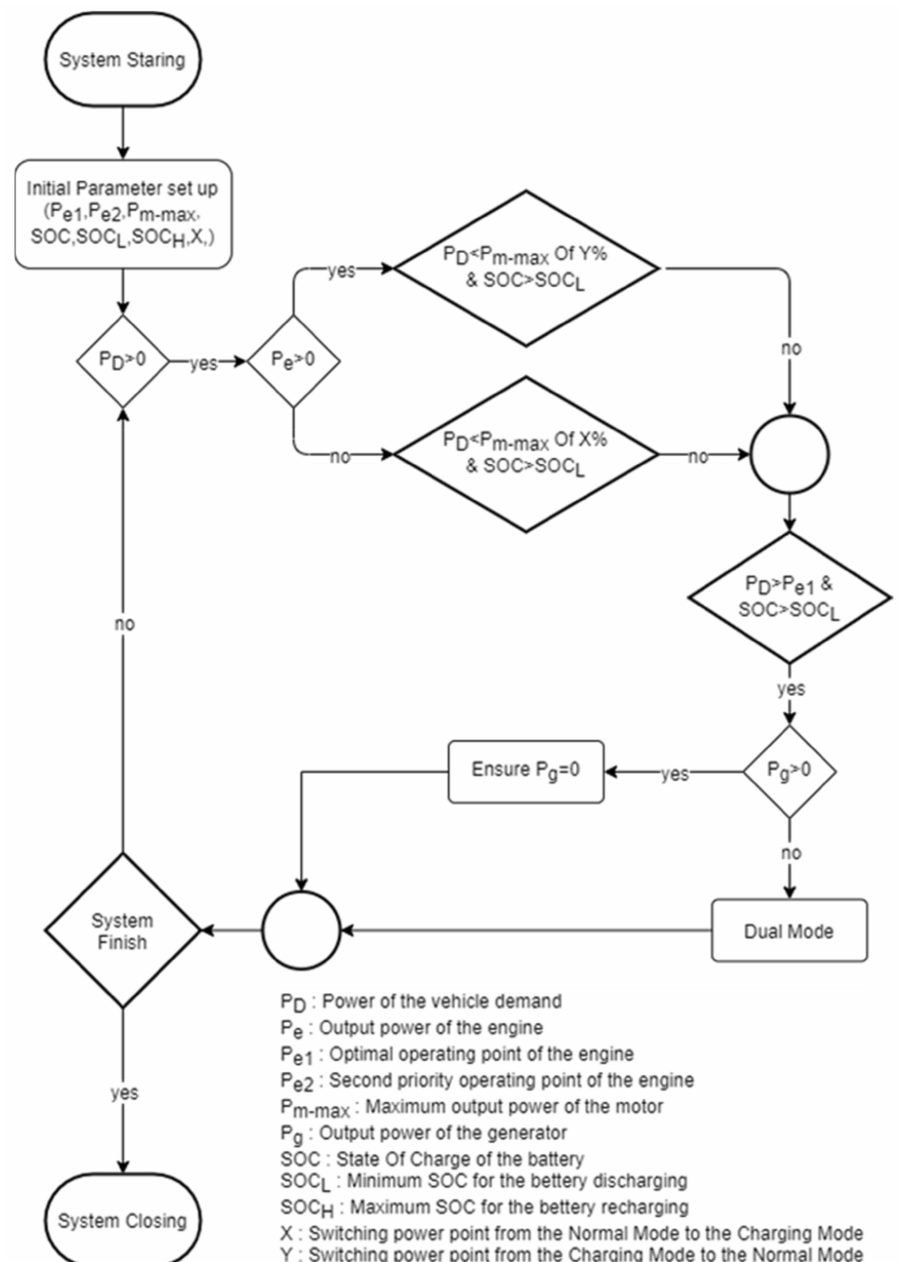
Figure 4. Flowchart of the dual-output control